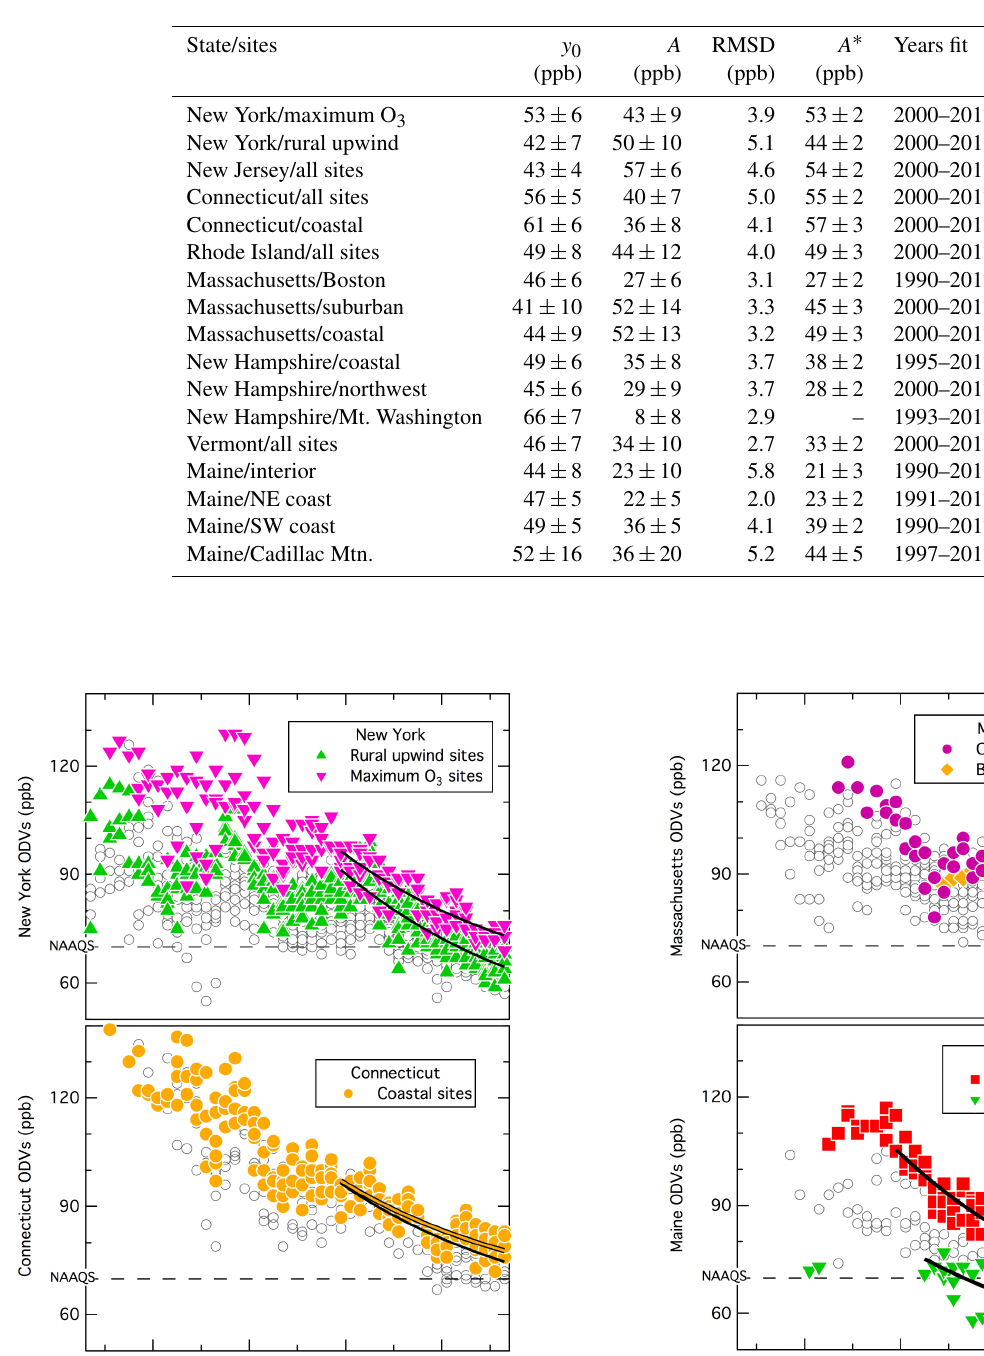
Table 2. Results of least-squares fits to Eq. (1) illustrated in Figs. 5–7 and S3–S10; RMSD indicates the root-mean-square deviation between the observed ODVs and the derived fit.